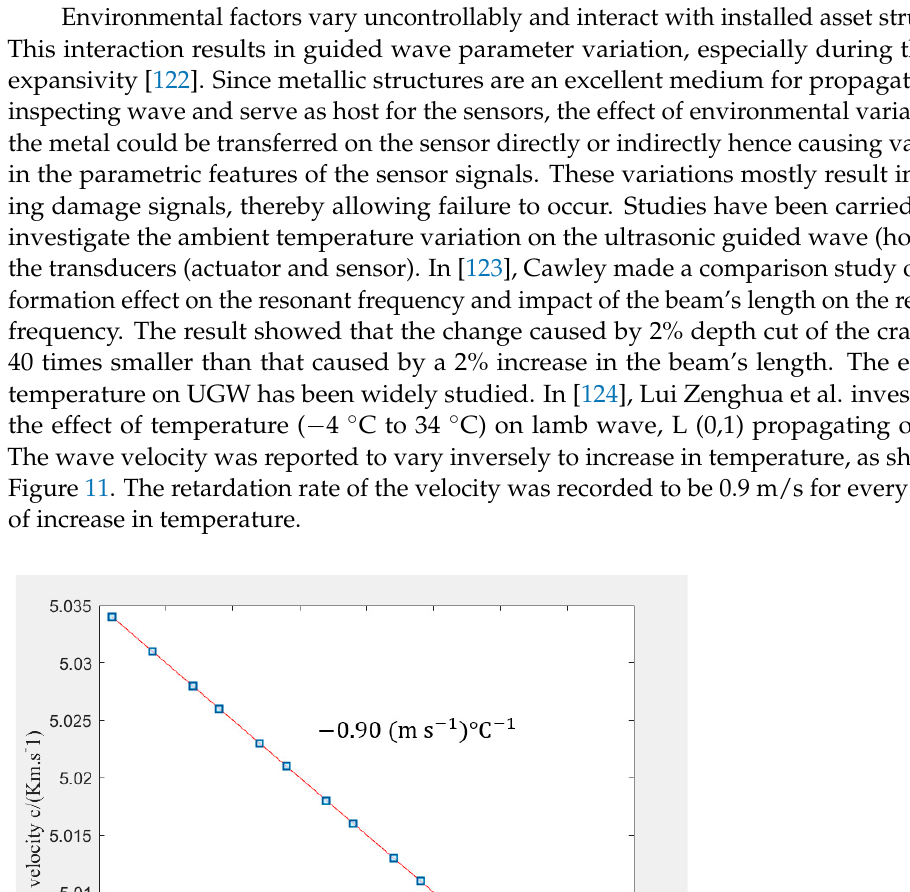
Figure 11. Temperature effect on Lamb wave velocity (R) [124].